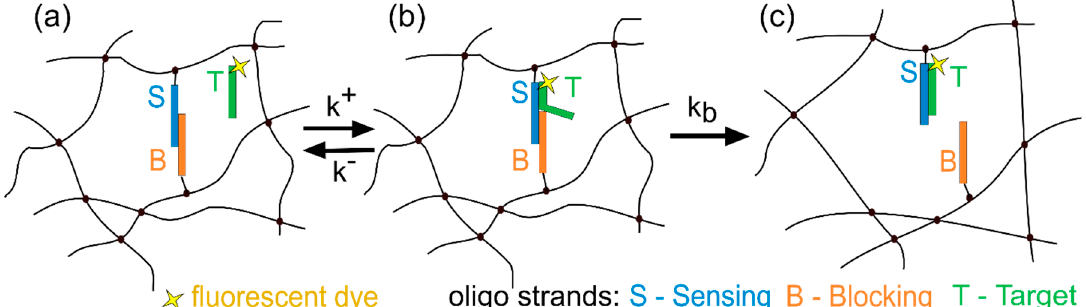
Figure 1. Dual-crosslinked polyacrylamide and nucleic acid (analogue) based hydrogel. In ( a ) the initial state of the crosslink composed of sensing and blocking strand, along with the free fluorescently labelled target. The target can bind ( b ) or dissociate from the crosslink with binding and dissociation rate constants k + and k − . Ultimately, ( c ) the blocking strand is entirely displaced after branch migration (k b ).